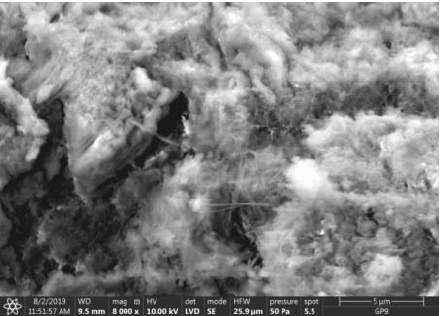
Figure 25. Microstructure of ZIII mortar (FBC I) after 90 days of curing in seawater solution.